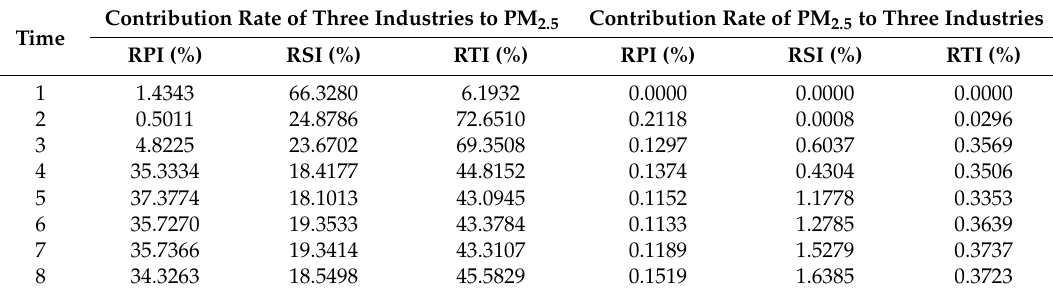
Table 6. The variance decomposition of three industries and PM